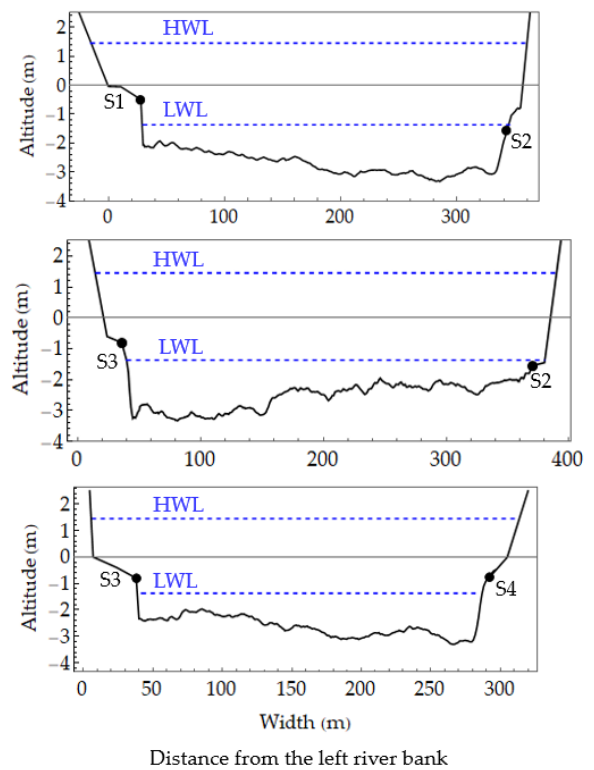
Figure 2. Oblique cross-sections along transmission lines between S1–S2, S2–S3, and S3–S4. Dashed lines denote the Highest Water Level (HWL) and the Lowest Water Level (LWL), and black dots denote the placed transducers.